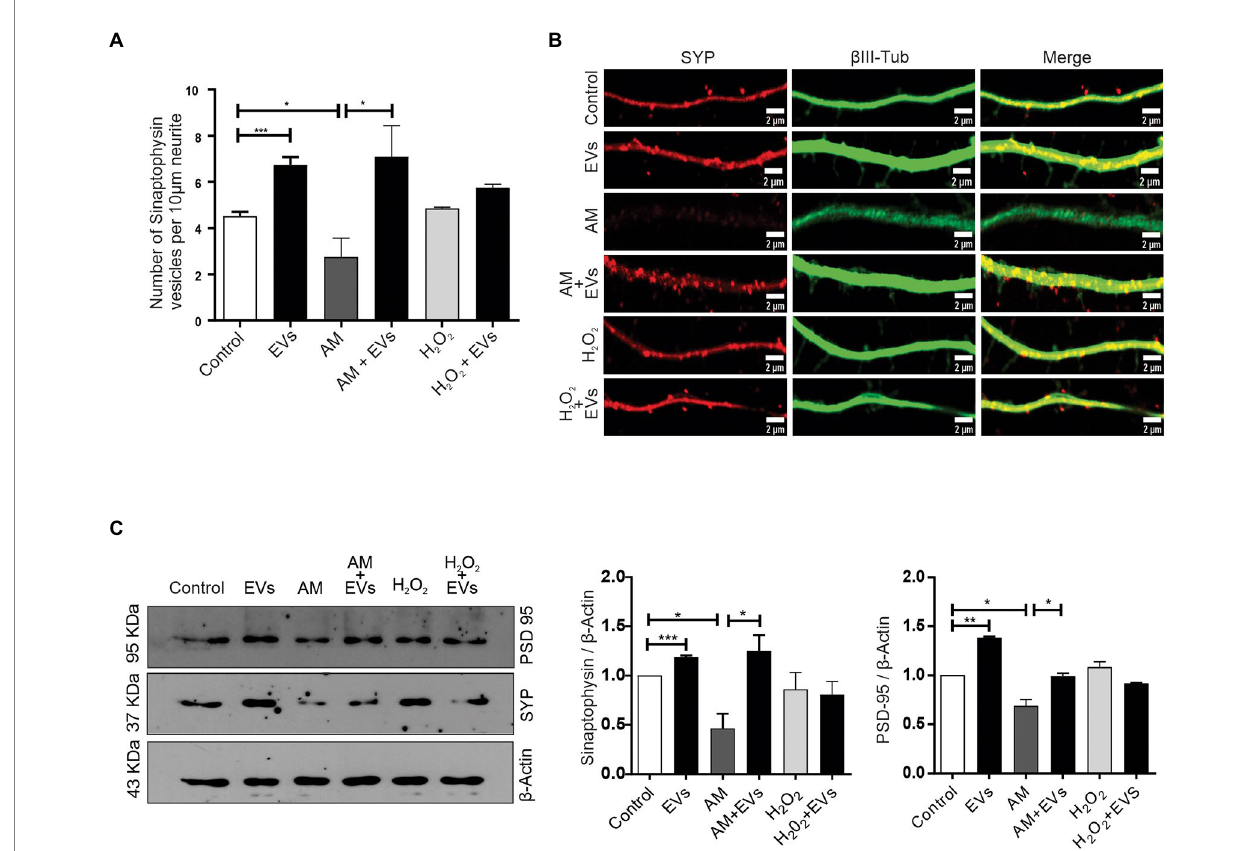
FIGURE 4 NSC-EVs promotes the expression of synaptic proteins. (A) Quantification of Synaptophysin vesicles. Graph represents the number of Synaptophysin- containing vesicles in 10 μ m length measured in three independent experiments. Data were presented as mean ± SEM. ** p < 0.01; * p < 0.05. (B) Representative images (63X) of the immunofluorescence assays with Synaptophysin (red) and the neuronal marker ( β III-tubulin, green) taken after 3 days of incubation in the indicated conditions. Scale bars: 1 μ m. (C) Representative image of Western Blot showing Synaptophysin (SYP) and PSD-95 levels in NSCs exposed under the indicated condition during 72 h. β -actin was used as control loading. The gels/blots displayed here are cropped, and without high-contrast (overexposure). Densitometry analysis was performed and the statistical differences were evaluated using Student’s T-test. *** p < 0.001; ** p < 0.01; * p <